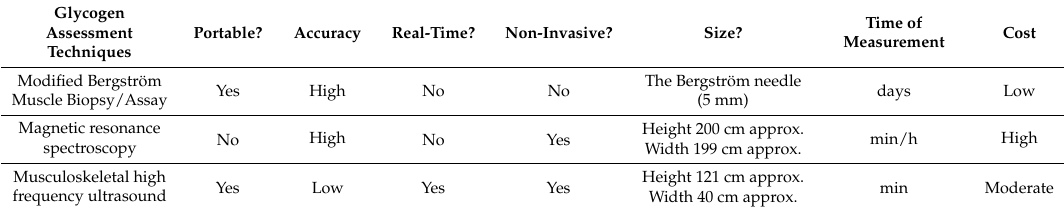
Table 1. Assessment of current techniques to detect muscle glycogen in